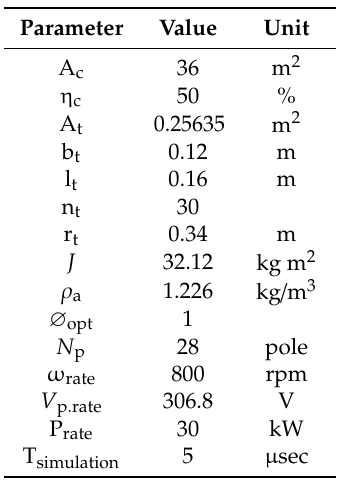
Table 1. Parameters and values in the simulations.